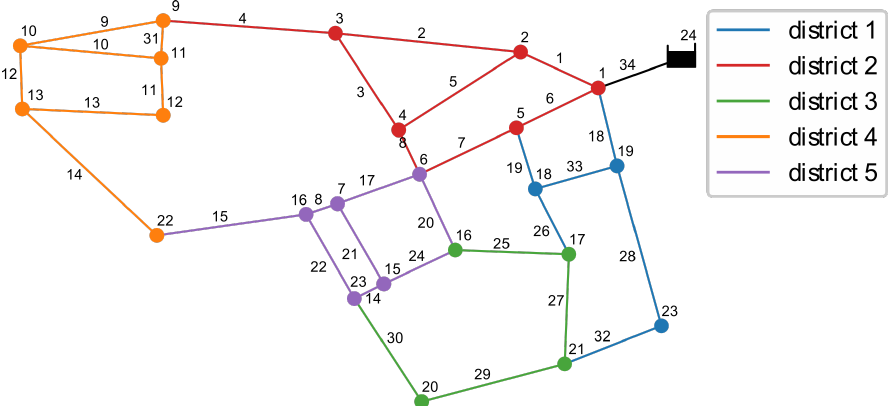
Figure 2. Layout of the Apulian network and its five